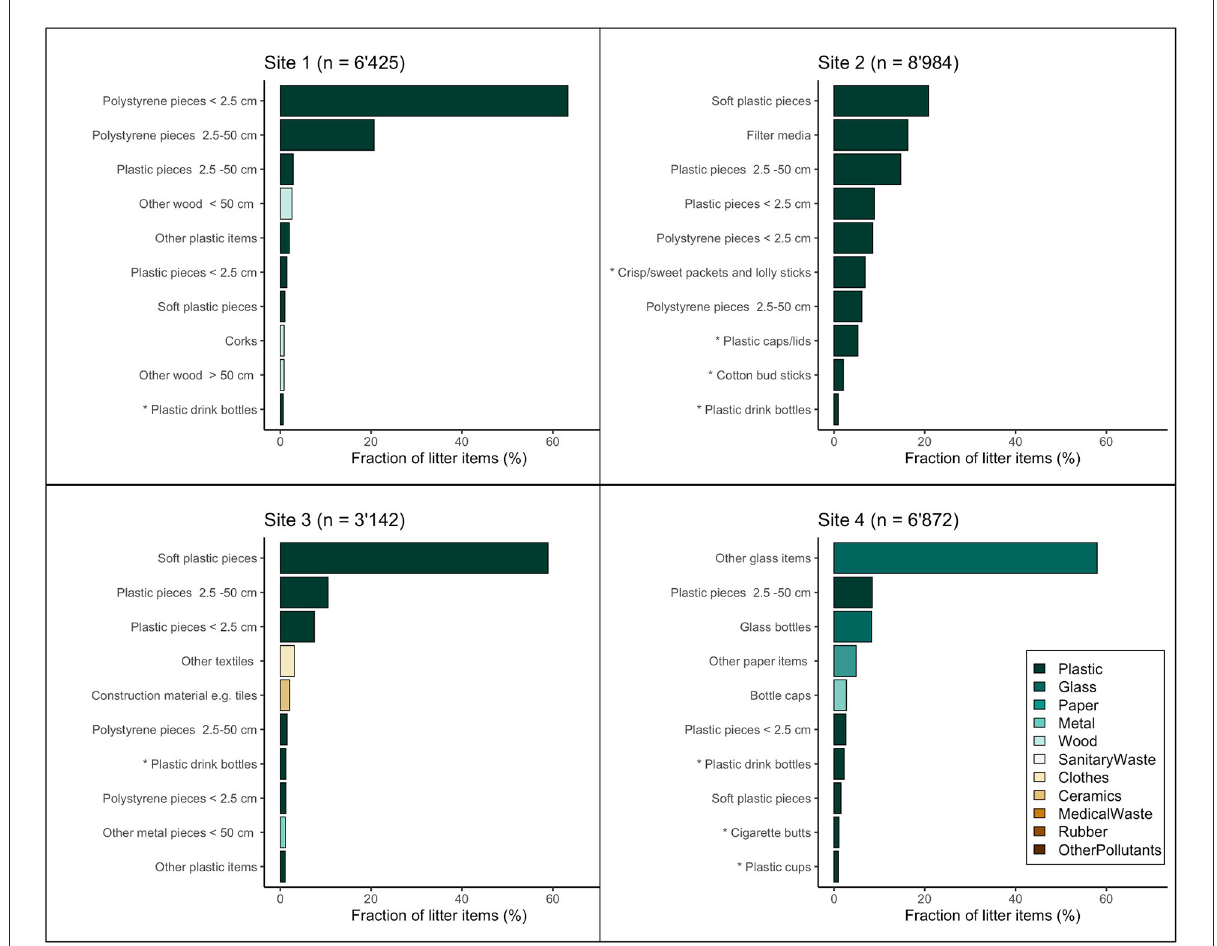
FIGURE5 Top litter items and materials at the four sampling sites. Top 10 litter items are shown as fraction of the total. SUP items are indicated (*).